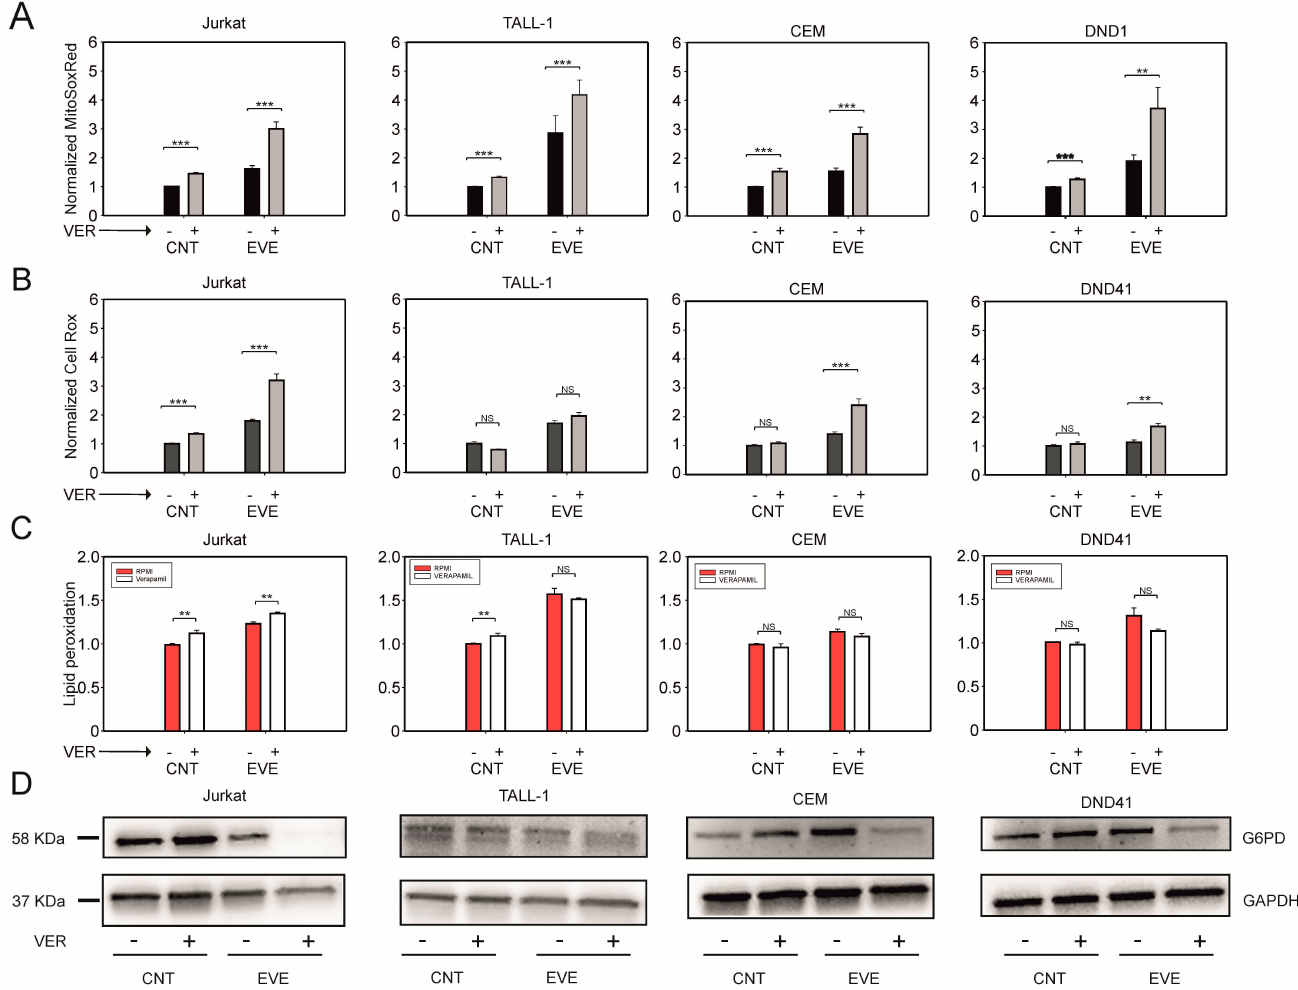
Figure 4. Verapamil enhances the perturbation of redox homeostasis induced by everolimus. ( A ) Plots of mean fluorescence intensity (MFI) values for the MitoSOX rRed fluorescent probe measured after 24 h of everolimus (EVE)/verapamil (VER) treatment and scaled against MFI values measured in the control cells. ( B ) Plots of MFI values for the CellRox Deep Red fluorescent probe measured after 24 h of everolimus/verapamil treatment and scaled against MFI values measured in the control cells. ( C ) Lipid peroxidation in T-ALL cells treated for 24 h with everolimus and verapamil. Shown are mean lipid peroxidation values (measured with the Image-iT Lipid peroxidation sensor). The mean values and standard error bars of three independent experiments with three replicates each obtained in Jurkat, TALL − 1, CEM and DND41 cells are shown. The indicated pairwise comparisons were statistically significant with the Mann-Whitney test; *** indicate p values < 0.001, ** < 0.01, NS = not significant. ( D ) G6PD expression in T-ALL cells treated with EVE (10 µ M) and/or VER (20 ng/mL). Shown are immunoblots from representative